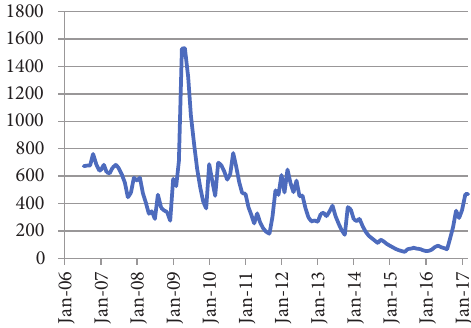
Figure 1. Volatility of monthly house prices